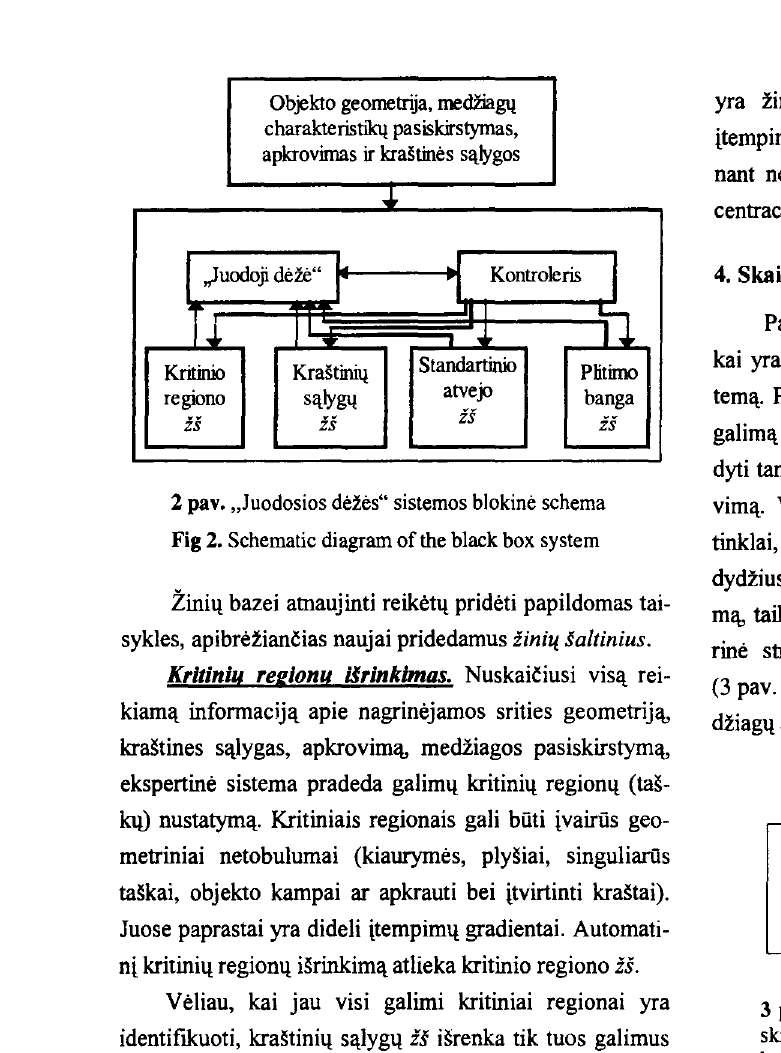
Fig 3. The first structure, when evaluated: a) only diffe rent materials; b) and c) different materials and loading Pirmosios inzinerines struktiiros BE tinklai yra